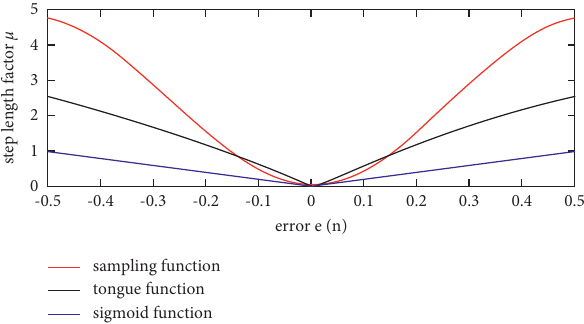
Figure 7: Step factor and error signal curve contrast diagram.